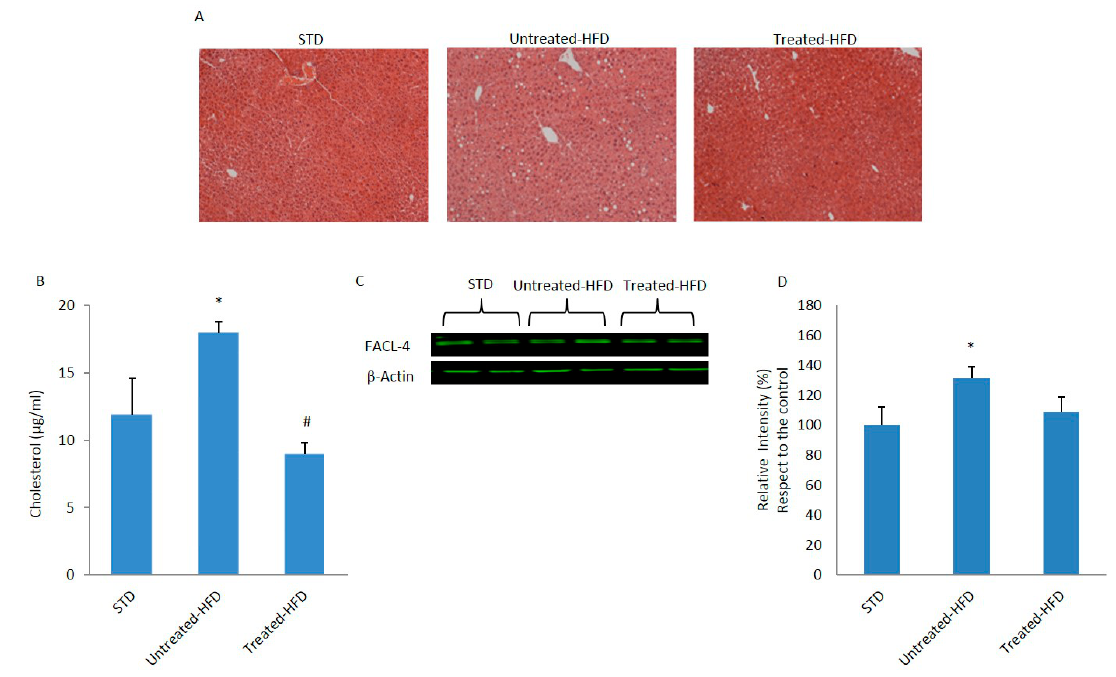
Figure 1. Effects of NDS on the liver. ( A ) Liver sections of control (STD), HFD (untreated-HFD) and NDS-treated (treated-HFD) mice; ( B ) Intrahepatic cholesterol concentration; ( C ) Western blot of proteins extracted from livers of STD, untreated-HFD and NDS treated-HFD mice and incubated with anti-fatty acid-CoA ligase-4 (FACL-4) and anti- β -Actin (loading control); ( D ) Quantification of immunoreactivity was performed using densitometric analysis. Data are the mean values ± SEM ( n = 8/group). * p ≤ 0.05 vs. STD; # p ≤ 0.05 vs. untreated-HFD.